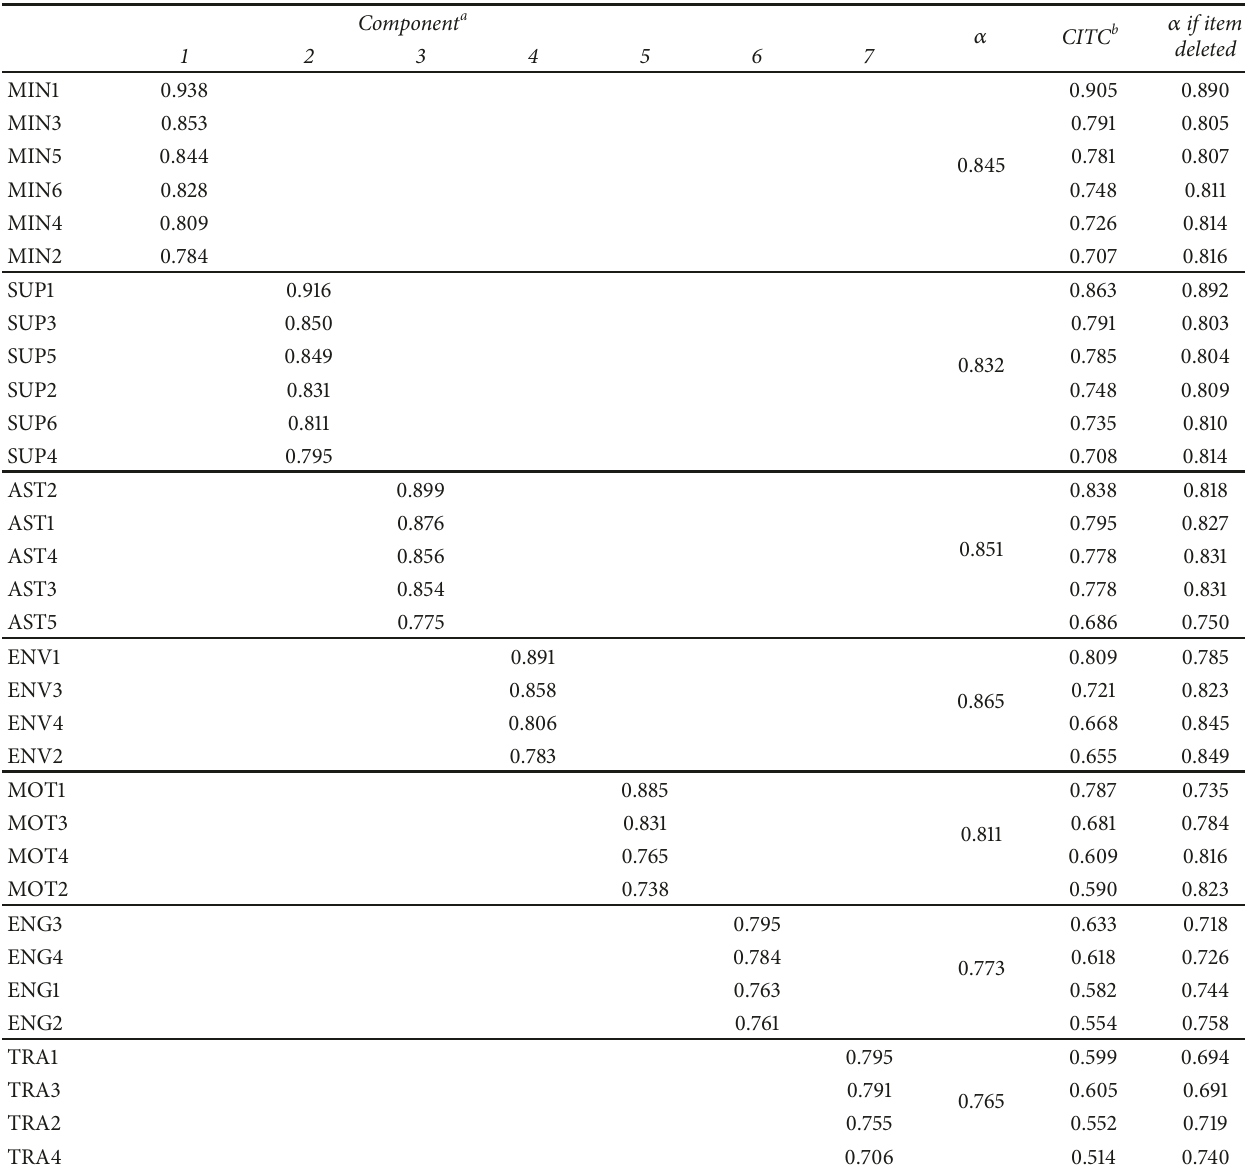
Table 4: EFA rotated matrix of independent variables and reliability